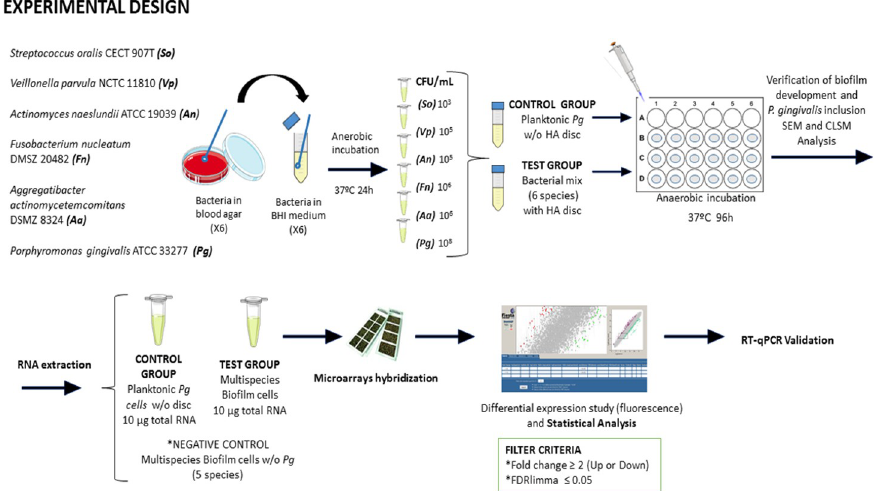
Fig 1. Overview of experimental design. P . gingivalis ATCC 33277 was incubated in anaerobiosis at 37˚C for 96 h and grown under planktonic conditions (control group) and within a multispecies-biofilm on hydroxyapatite (HA) discs, also containing the other described five bacterial species (test group). Scanning Electron Microscopy (SEM) and Confocal Laser Scanning Microscopy (CLSM) were used to verify the multispecies-biofilm development and the presence of P . gingivali s in it. Total RNA was extracted, purified and the differential gene expression was analyzed by microarray [Agilent P . gingivalis Oligo Microarrays 8x15K (074976)] with a filtering criterion of two-fold change (up or down) and significance p-value < 0.05. Differential expression was confirmed by Reverse Transcription-quantitative Polymerase Chain Reaction (RT-qPCR). (Images for Fig 1 were taken from https://smart.servier.com/ under a creative commons